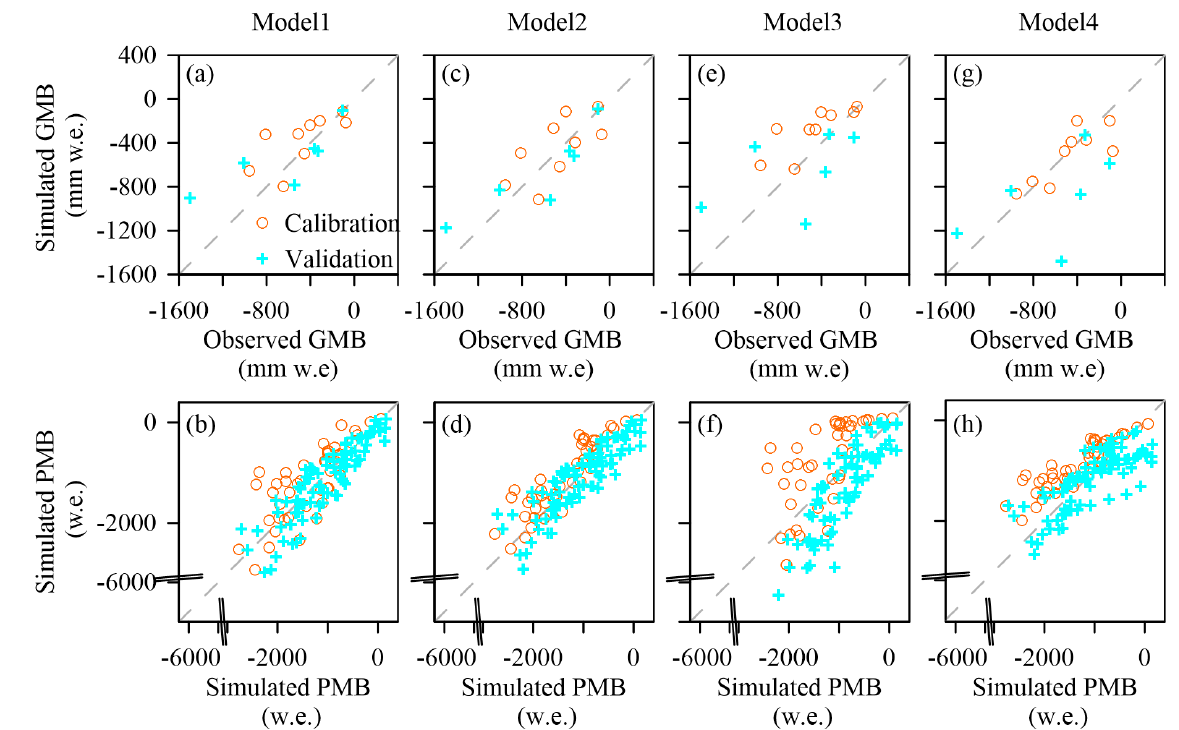
Figure 5. The modeled glacier mass loss and stake measured mass loss as well as point mass loss of the Qiyi Glacier by using the four sub-models. In the figure, the red circles are the data of calibration period and the blue crosses are the data of validation period; ( a , c , e , g ) are the simulated GMB (Glacier Mass Blalnce for the whole glacier) results of the four sub-models; ( b , d , f , h ) are the simulated PMB (Poin Mass Balance of the glacier).